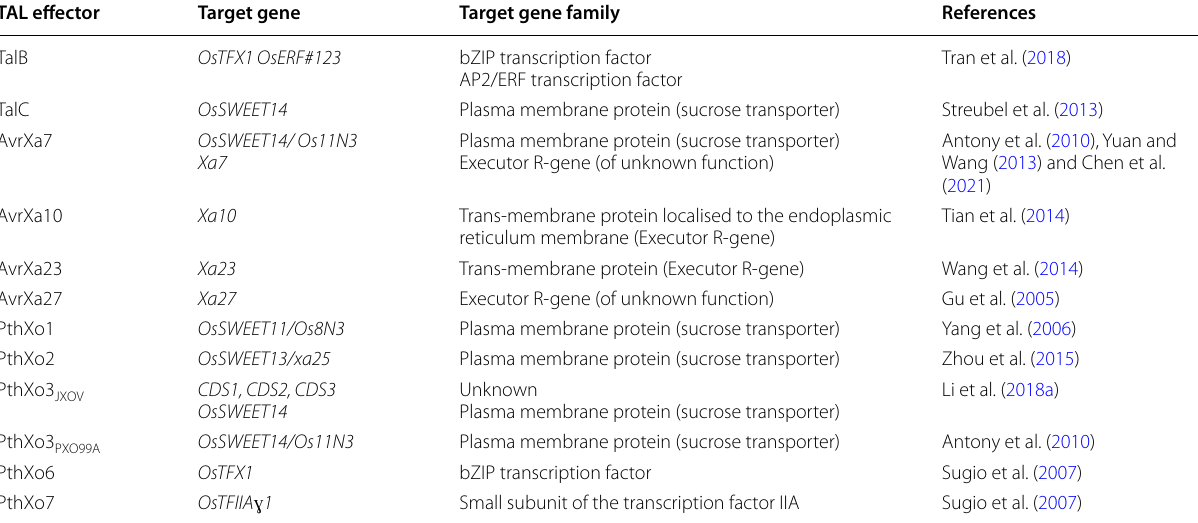
Table 1 TAL effectors of